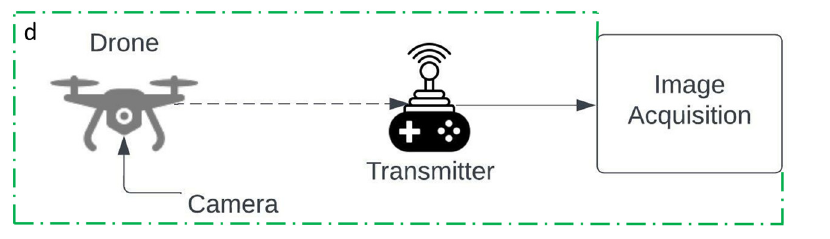
Figure 3. Implementation of image-based devices and systems. ( a ) 2D vision system for digital image correlation; ( b ) 3D vision system for digital image correlation; ( c ) Novel inspection system using inspection robot; ( d ) UAV photogrammetry for displacement monitoring.